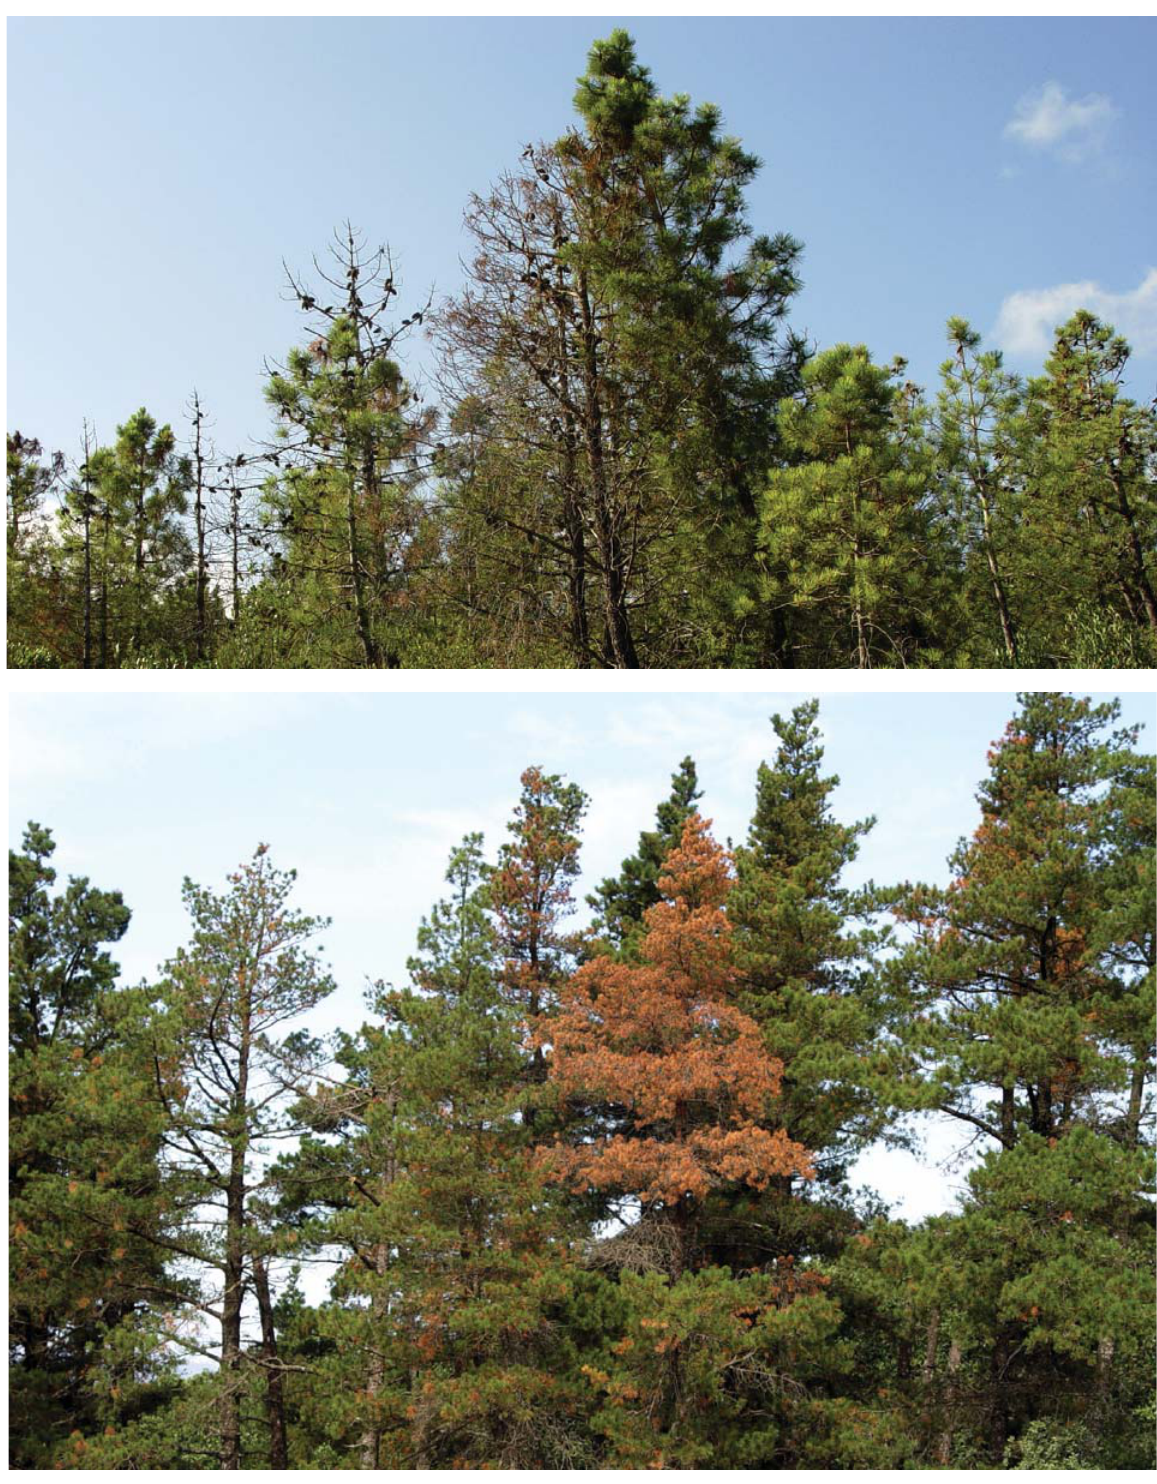
Fig. 1. Disease symptoms associated with Diplodia pinea infection on Pinus pinaster (top) and Pinus radiata (bottom)